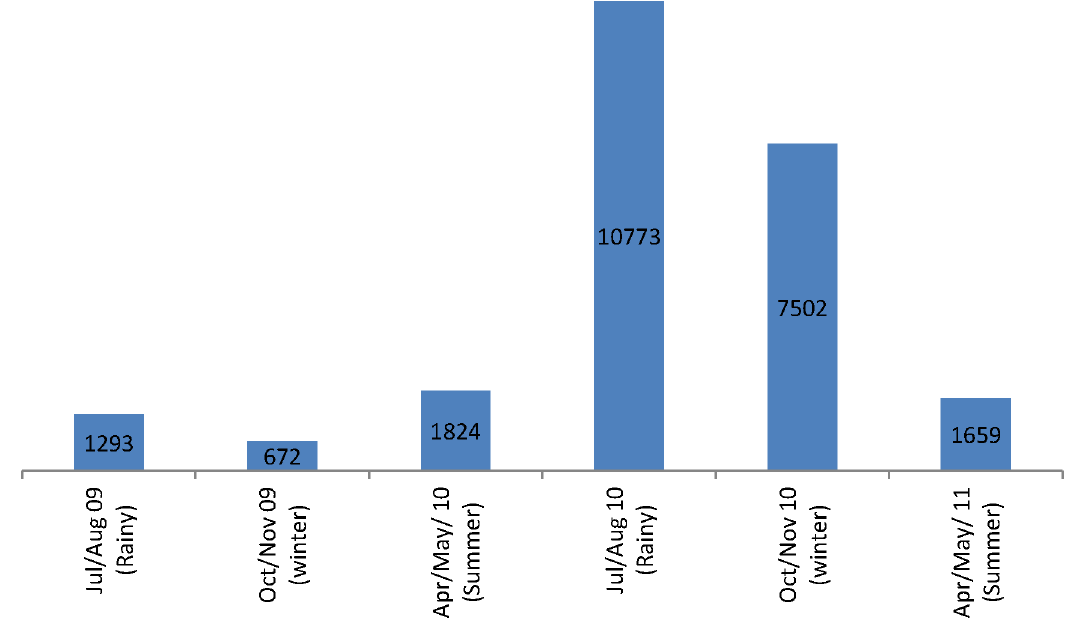
Figure 2. Phlebotomusargentipes abundance during three annual peaks of the two study years.